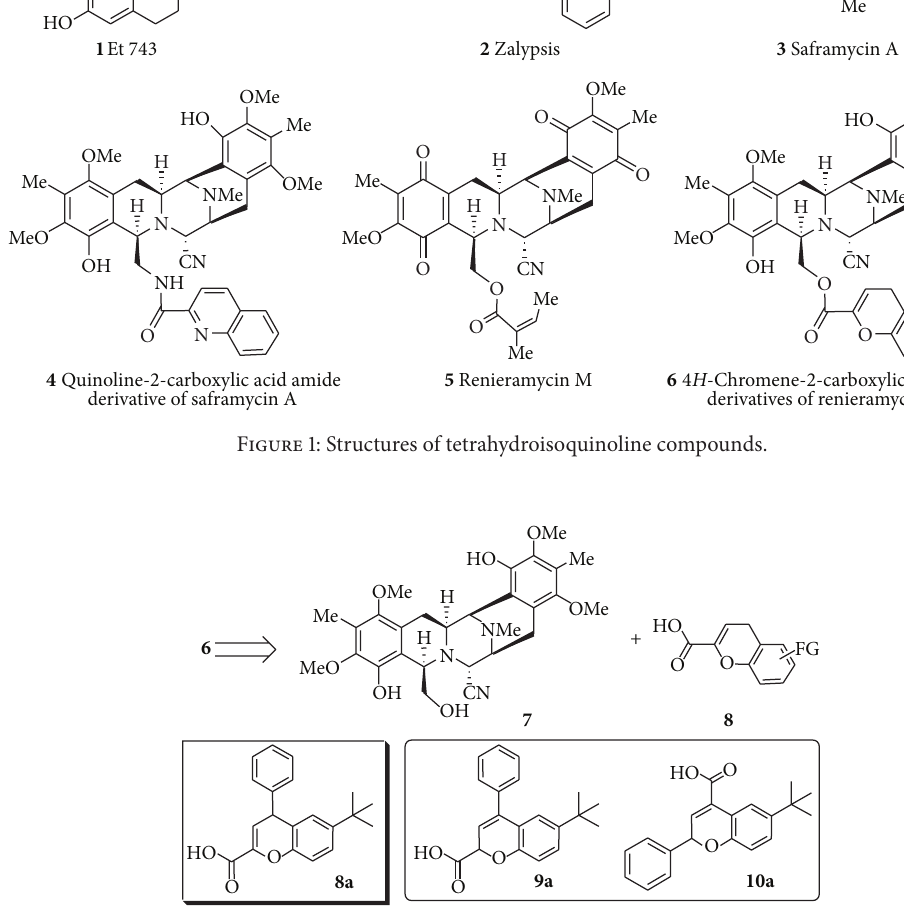
Scheme 1: Retrosynthetic